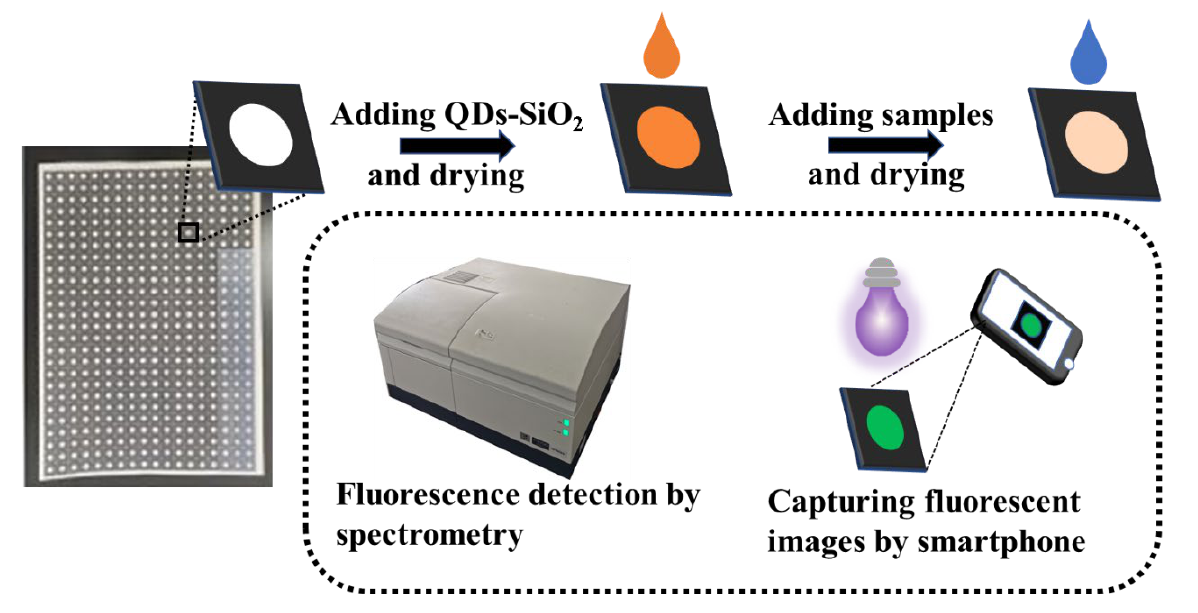
Figure 1. Schematic diagram of the manufacturing and testing of the paper-based chip.